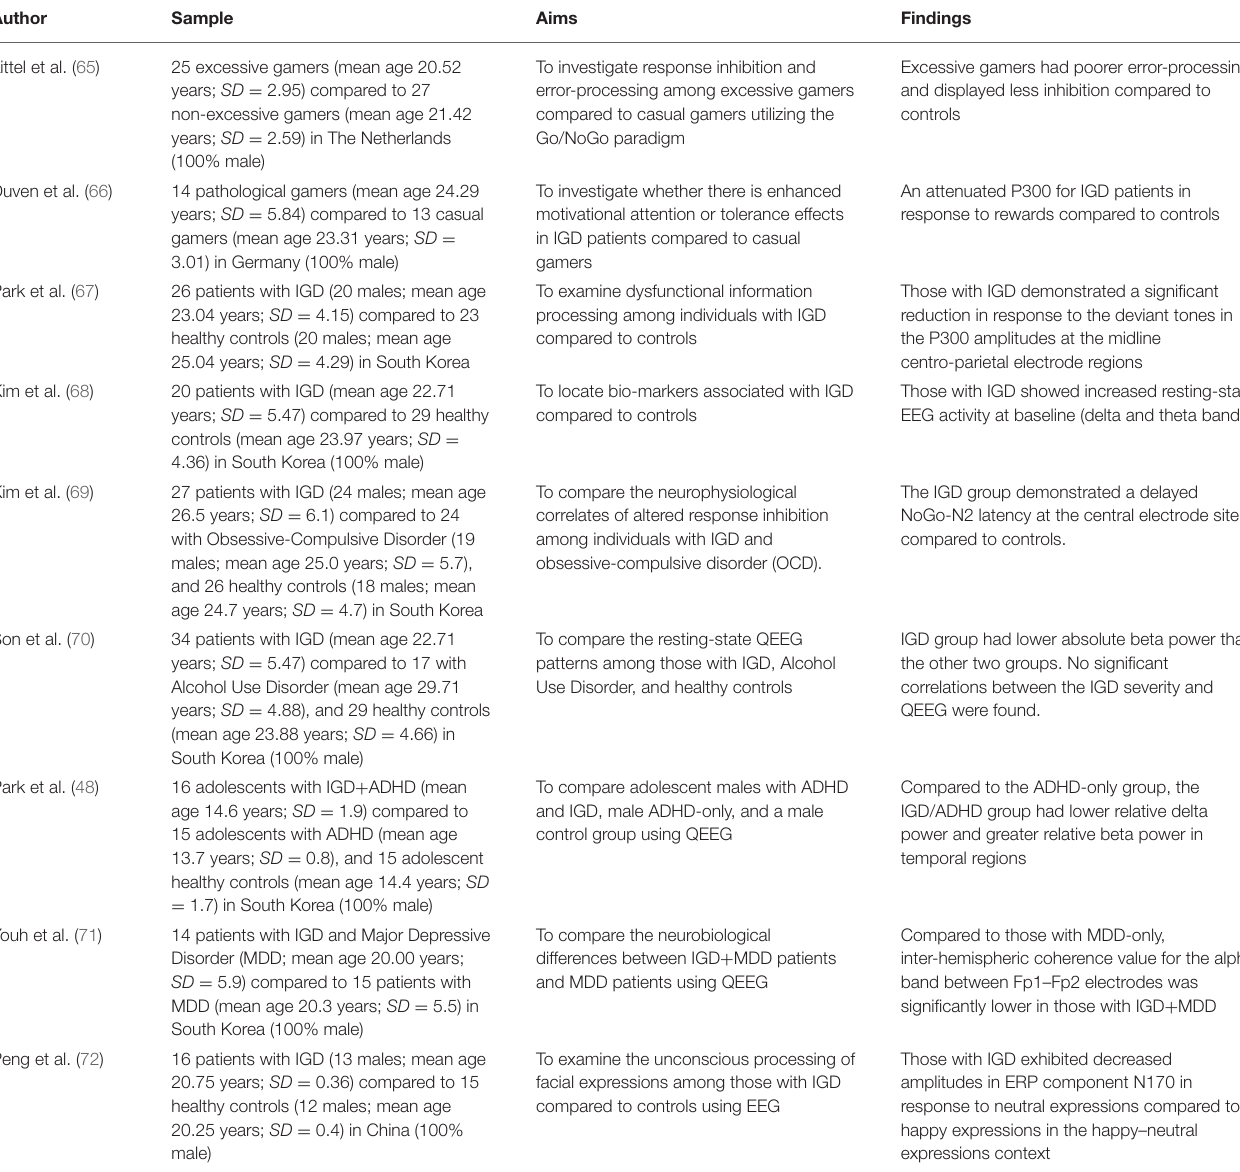
TABLE 5 | EEG studies examining gaming addiction/Internet Gaming